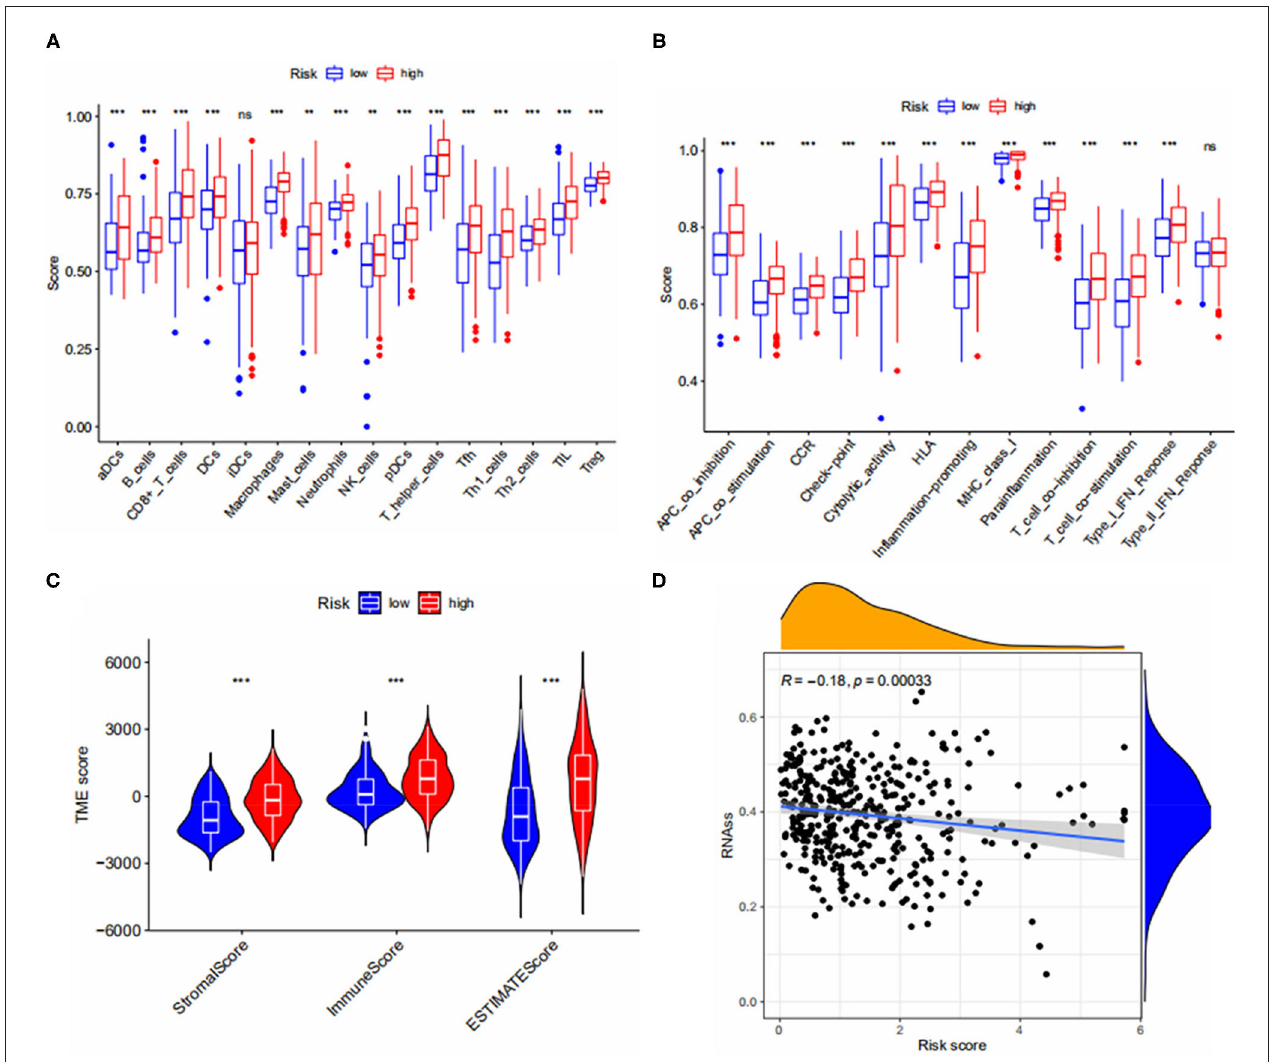
FIGURE 6 | (A,B) Immune cell infiltration and immune pathway activity scores in both risk groups. (C) Correlations between risk groups and both immune and stromal scores. (D) Relationship between CSC Index and risk score. *** <